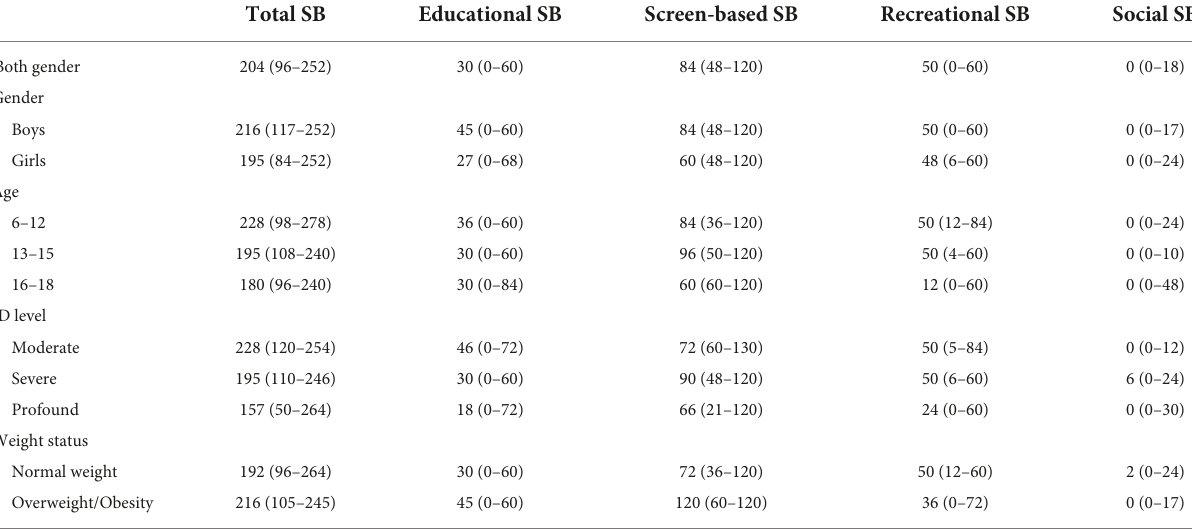
TABLE 1 Daily minutes of total after-school SB and specific types of after-school SB among children and adolescents with ID [M (P25–P75),